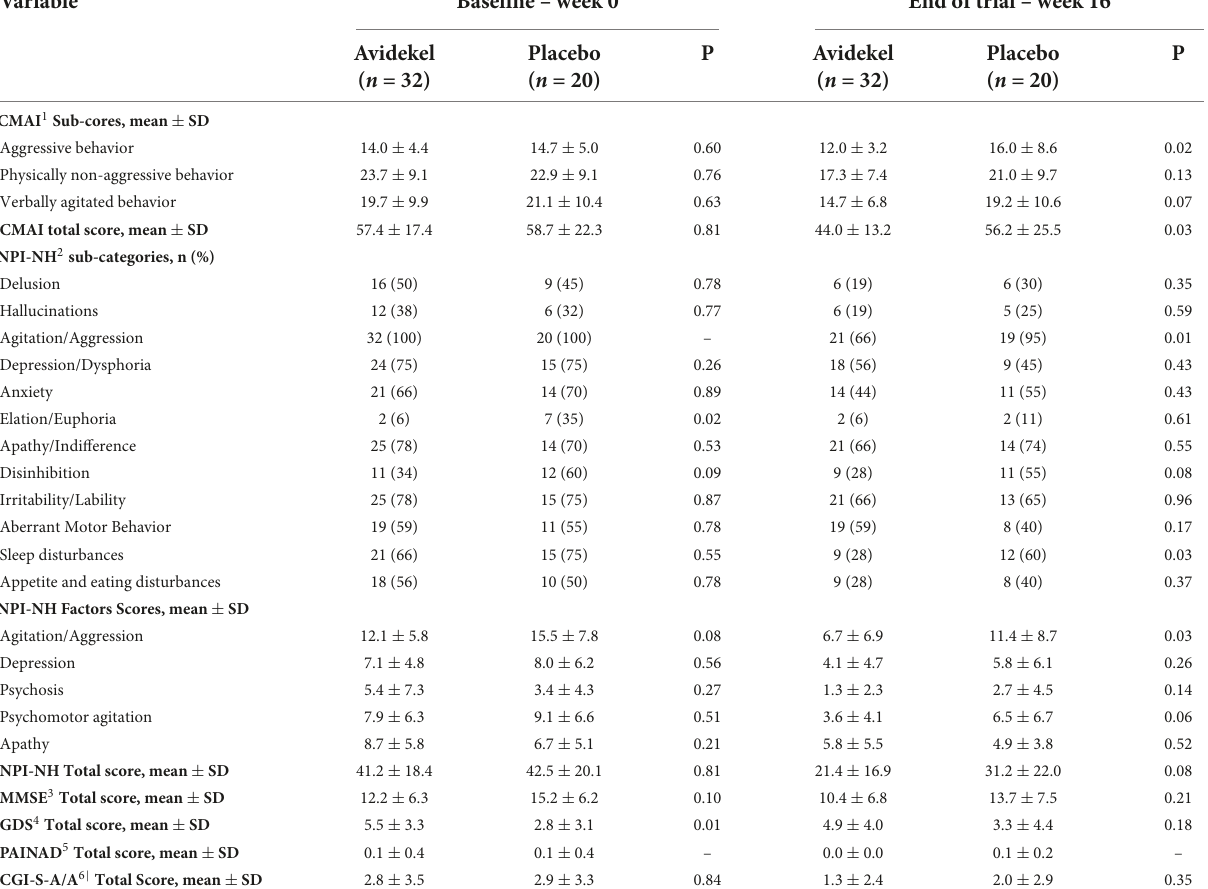
TABLE 2 Effects on neuropsychiatric signs and symptoms for completers, at baseline and end of trial. Variable Baseline – week